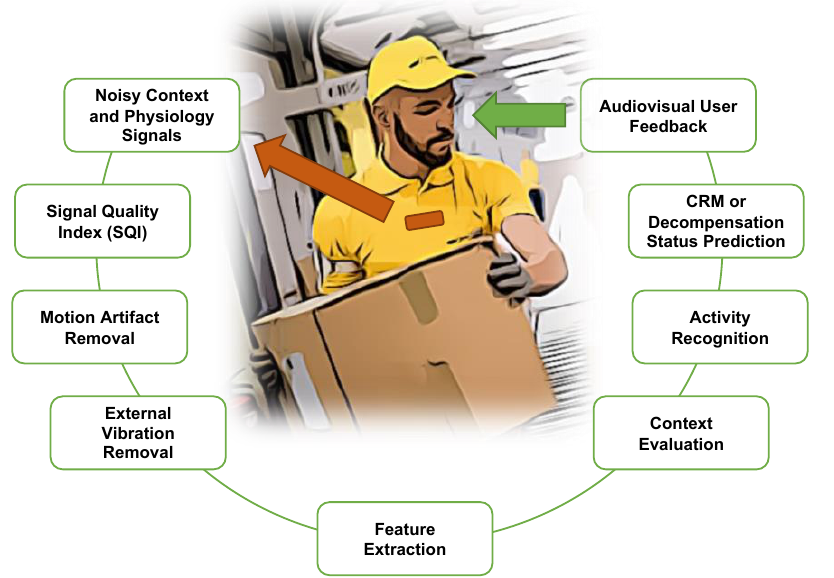
Figure 15. Processing stages in an example use case. Noisy signal recordings from a ruggedized chest-worn sensor (brown) go through a signal quality assessment and then motion and external vibration removal prior to feature extraction. Once high-quality features are extracted from the signals, predictions and evaluations of context, activity and reserve or decompensation status can be made. This summarized information is then relayed back to the user.